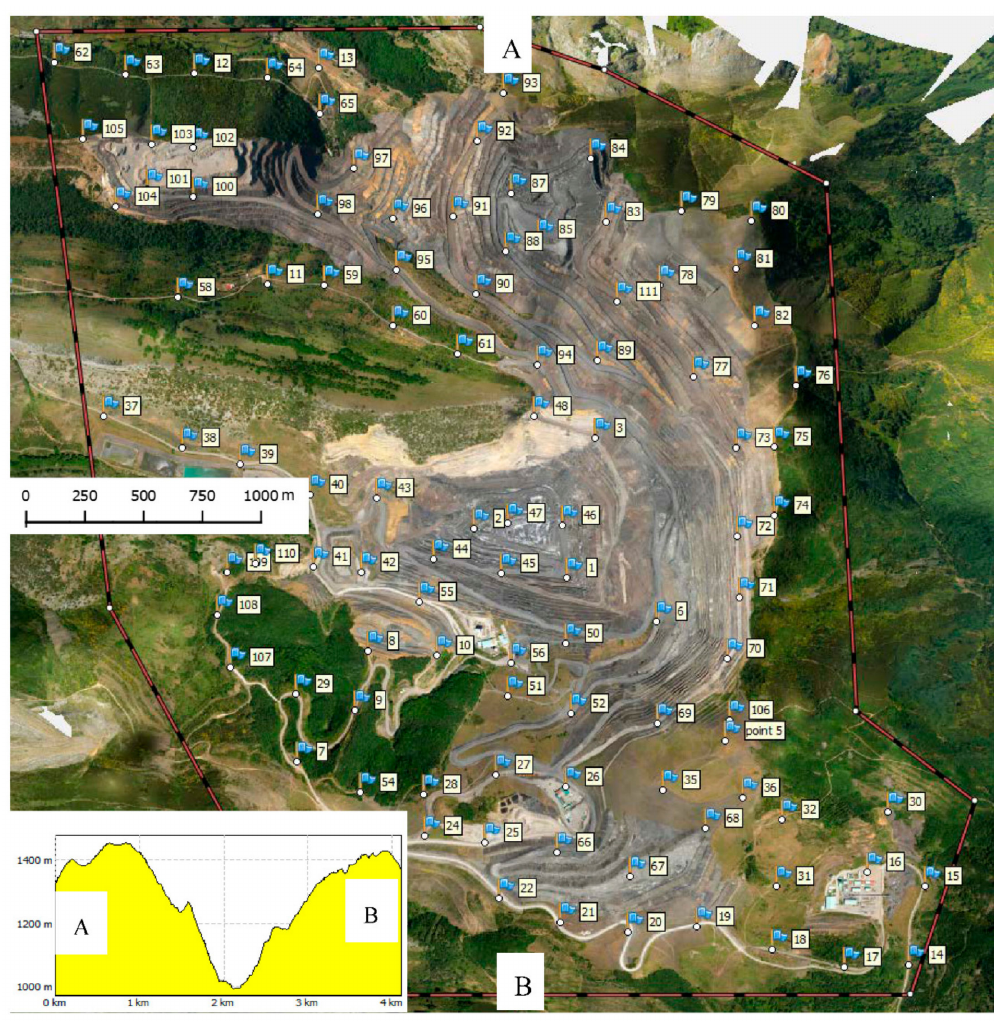
Figure 1. The orthophoto illustrates the study area surrounded by a black and red polyline. The figure also shows the even distribution of ground control points (GCPs), with the inset providing a profile along a N-S central